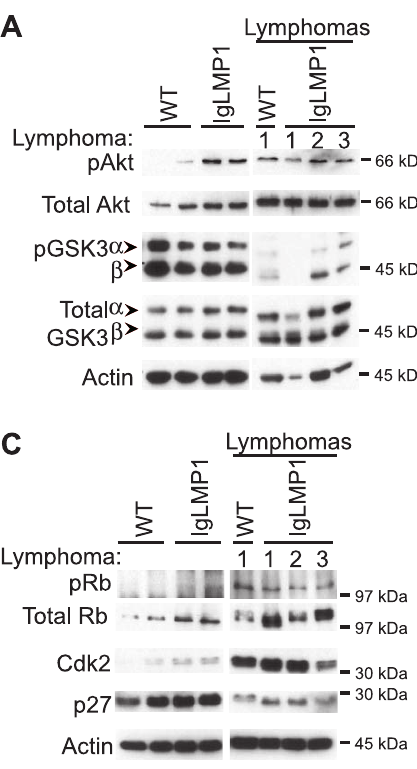
Figure 6. LMP1 Activates Akt Signaling and Deregulates the Rb Cell Cycle Pathway (A and B) Immunoblot analysis of purified B cells (CD19 þ ) from the spleens of WT and LMP1 transgenic mice for Akt signaling, probing for (A) activated pAkt and downstream targets, including inactivated pGSK3 a / b , and (B) activated p-mTOR, and total levels of FoxO1. Arrows indicate the positions of a and b isoforms of GSK3. The white line indicates that intervening lanes have been spliced out. (C) Immunoblot analysis for cell cycle proteins regulating the Rb pathway, probing for activated pRb, and total levels of Cdk2 and the Cdk inhibitor p27. Actin was used as a loading control.